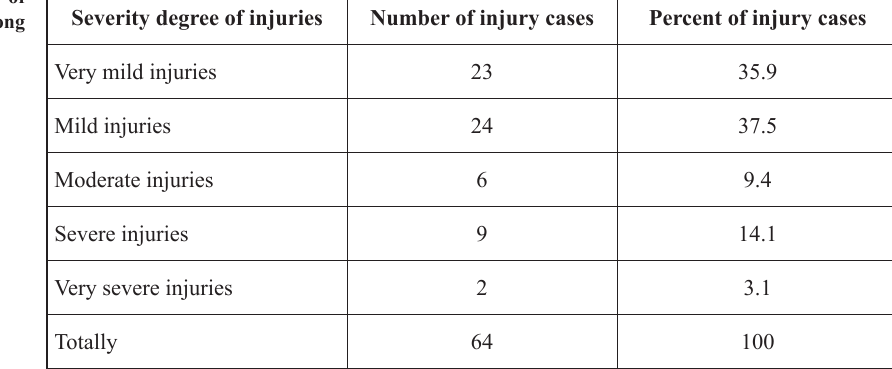
Severity degree of examined among throwers and sprinters